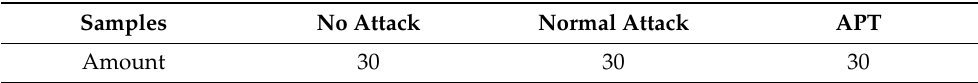
Table 2. Samples distribution.